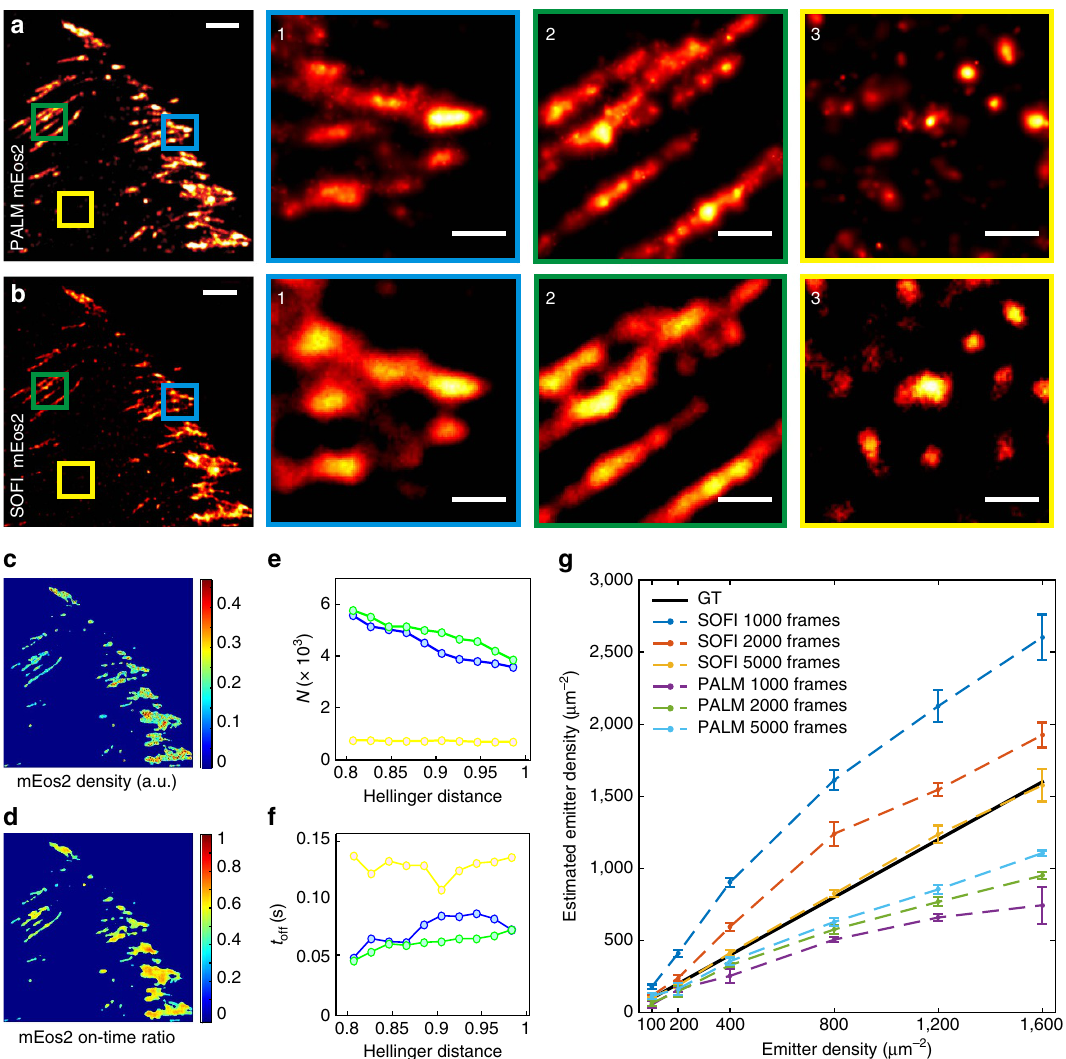
Figure 5 | Quantitative imaging with PALM and SOFI. ( a , b ) PALM and SOFI images of a fixed MEF cell expressing paxillin labelled with mEos2. Panels 1–3 are corresponding zoom-ins for the PALM or SOFI images. The PALM images were rendered as probability maps (see Methods). Scale bar, ( a , b ) 2 m m; (1–3) 0.5 m m. ( c , d ) SOFI analysis yields a fluorophore density and on-time ratio map. ( e , f ) Blinking events in PALM data can be detected by merging localizations that are sufficiently close in space and time. This analysis yields the blink corrected number of localizations N and the corresponding average off-time t off between blinks, shown as a function of the Hellinger distance threshold for merging localizations. ( g ) SOFI and PALM-based quantitative analysis performed on simulated data (Supplementary Note 2). The emitter density estimated by PALM and SOFI is shown in function of the ground truth (GT) density for different numbers of simulated frames. The procedure was repeated 10 times, the error bars represent the s.d. The Hellinger distance threshold for the PALM-based estimation is 0.90 (Supplementary Note